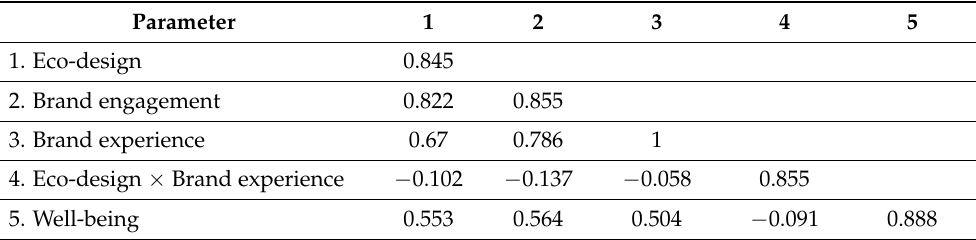
Table 3. Outcomes of the Fornell–Larcker (F-L)